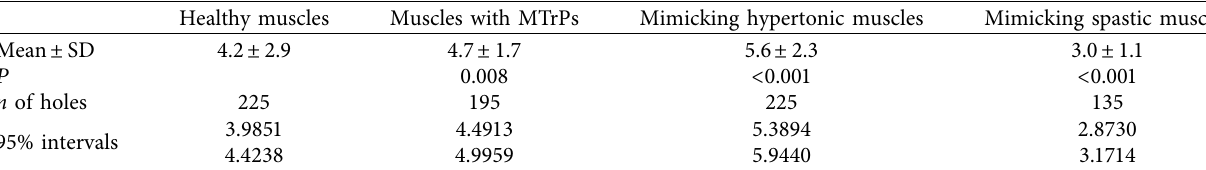
Table 1: Number of fibers injured by puncture (LAL muscle).